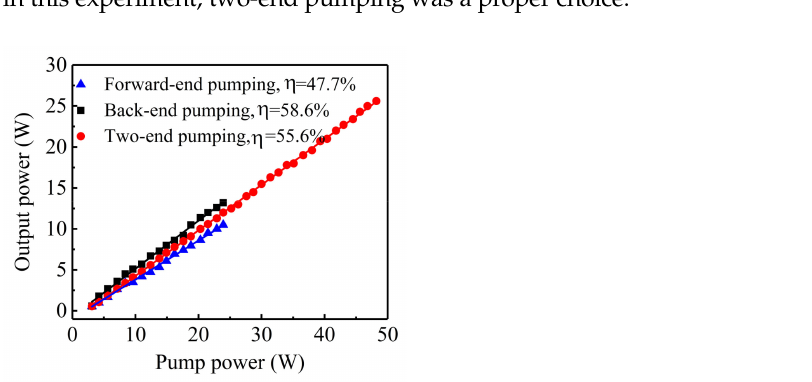
Figure 7. Output power of the main amplifier with increasing pump